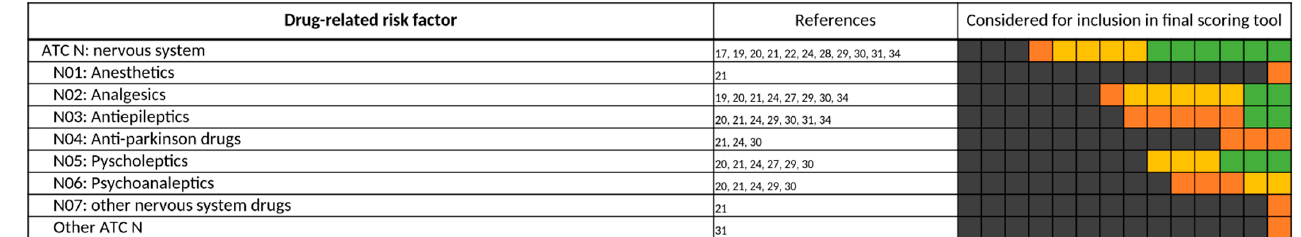
Figure 6. Drug classes of the ATC N (nervous system) class. Each of the 14 boxes represents one of the included studies. The color of the boxes portrays whether a risk factor was not investigated in a study (gray), was investigated (orange), was significant in a first statistical analysis or based on expert consensus and therefore tested for inclusion in a final scoring tool (yellow), or whether a risk factor was included in a final scoring tool (green). The “citations”-column lists each study that at least investigated the respective risk factor.